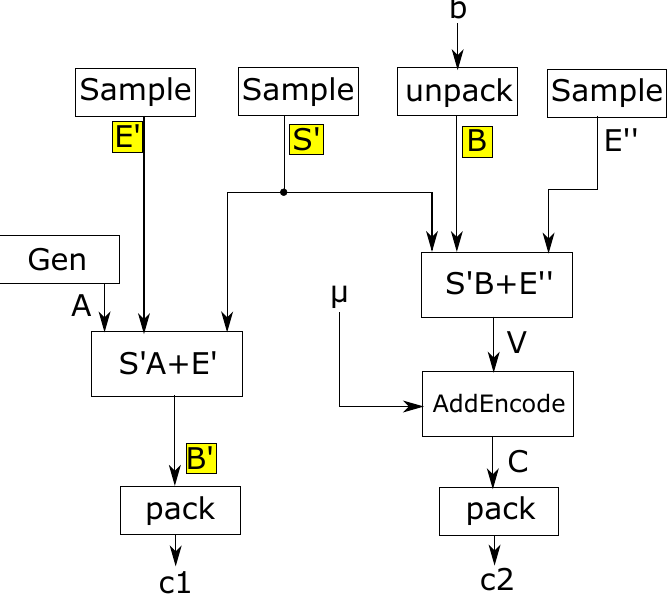
Figure 3: Flowchart of the encapsulation. Yellow highlighted matrices are n × ¯ n